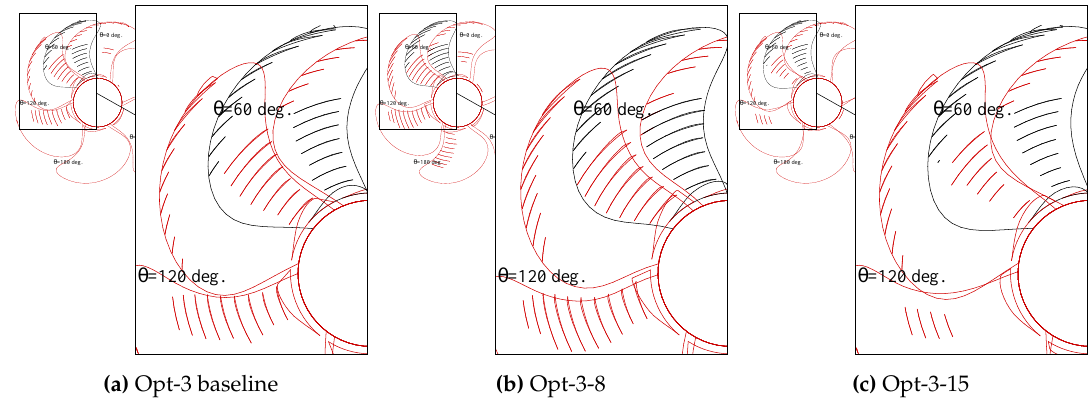
Figure 16. Cavitation prediction of propeller Opt-3. ( a ) Opt-3 baseline; ( b ) Opt-3-8; ( c ) Opt-3-15.